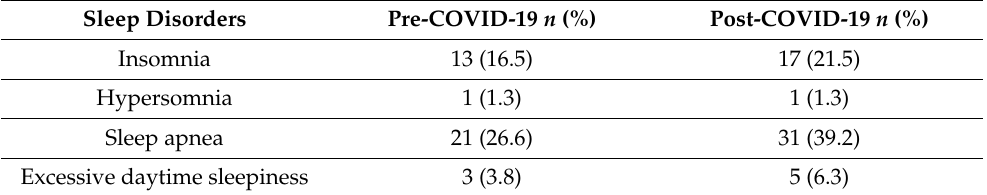
Table 4. Descriptive statistics of sleep disorders between pre-COVID-19 and post-COVID-19 infection. Sleep